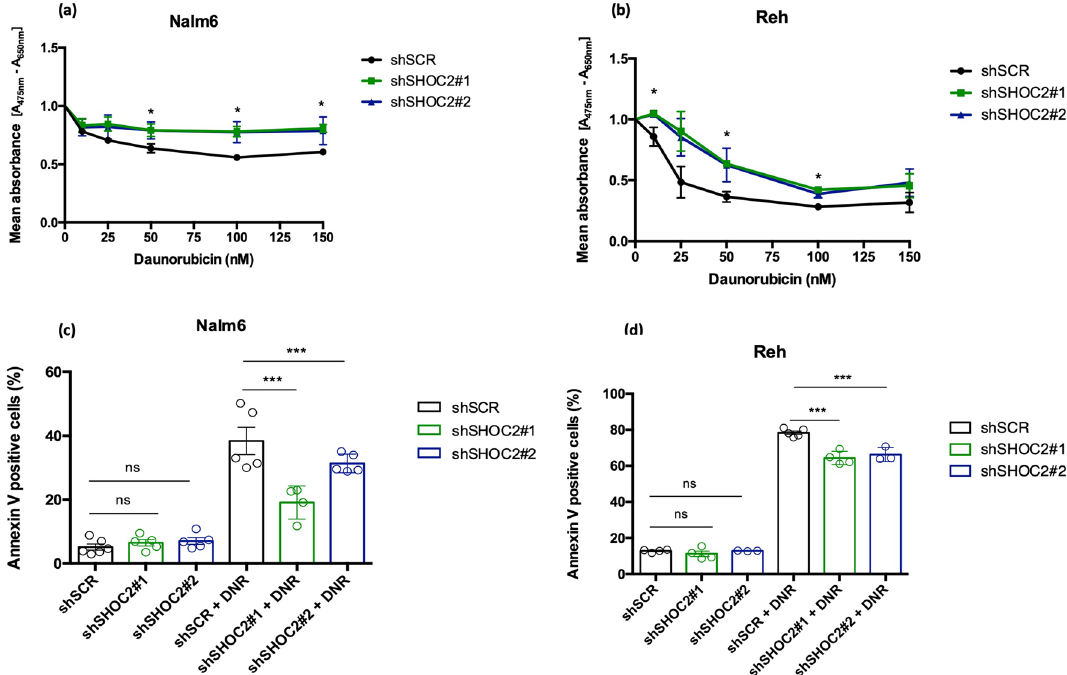
Figure 2. ( a , b ) Cell viability of Nalm-6 and Reh cells stable transduced with shRNA for SHOC2 or SCR control were evaluated in a 4-day MTT assay after treatment with increasing concentrations of Daunorubicin (10ηM, 25ηM, 50ηM, 100ηM and 150ηM). Results are expressed as mean absorbance [A475 nm–A650 nm] with standard deviation (S.D.) from three independent experiments. Representative viability curves after 72 h of Daunorubicin exposure show how SHOC2 absence has greatly increased daunorubicin resistance (* p < 0.05). ( c , d ) SHOC2 inhibition cleared impaired apoptosis-induced cell death in both Reh and Nalm-6 cells (*** p < 0.001) after Daunorubicin treatment for 72 h (respective IC 50 values). The bar-graphs represent mean with S.D. from three independent experiments. Statistically significant analyses are indicated by asterisks: * p < 0.05, ** p <